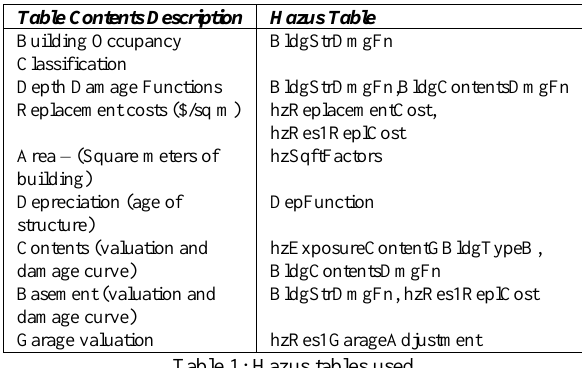
Figure 1. Flow diagram for ER 2 . White boxes indicate user inputs, grey are computed interim values, and green and red are computed valuation and estimated damages